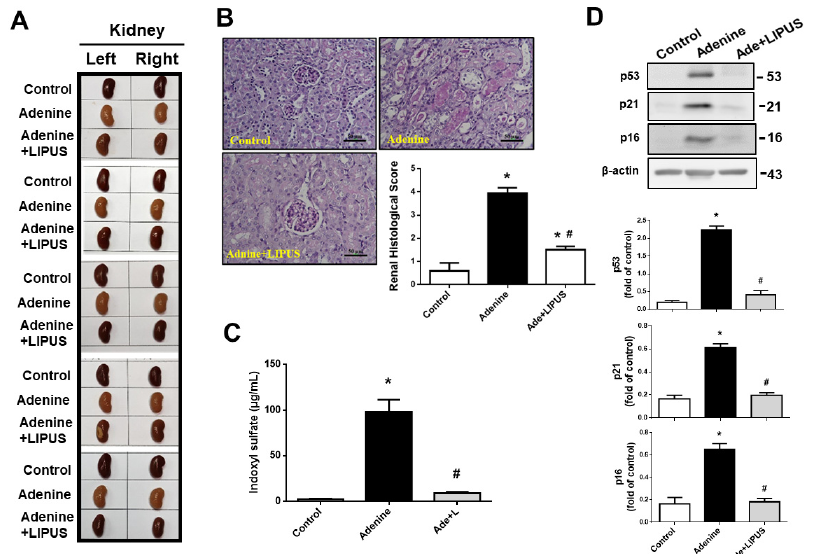
Figure 6. The effects of LIPUS on renal histology and serum indoxyl sulfate levels in CKD mouse models following adenine administration (the mice were euthanized 28 days after adenine administration): ( A ) the gross appearance of both the left and right kidneys; ( B ) pathological changes in renal tissue sections from the left kidneys stained with Periodic acid–Schiff (PAS), which were analyzed using a light microscope, and histological score (scale bar: 50 μ m); ( C ) serum indoxyl sulfate levels; ( D ) senescence-related molecules (p53, p21, and p16) in the left kidneys, determined by Western blot. Quantifications for the protein expression are also shown. Data are presented as mean ± SD (n = 5–9): * p < 0.05 versus the control group; # p < 0.05 versus the CKD-alone group.